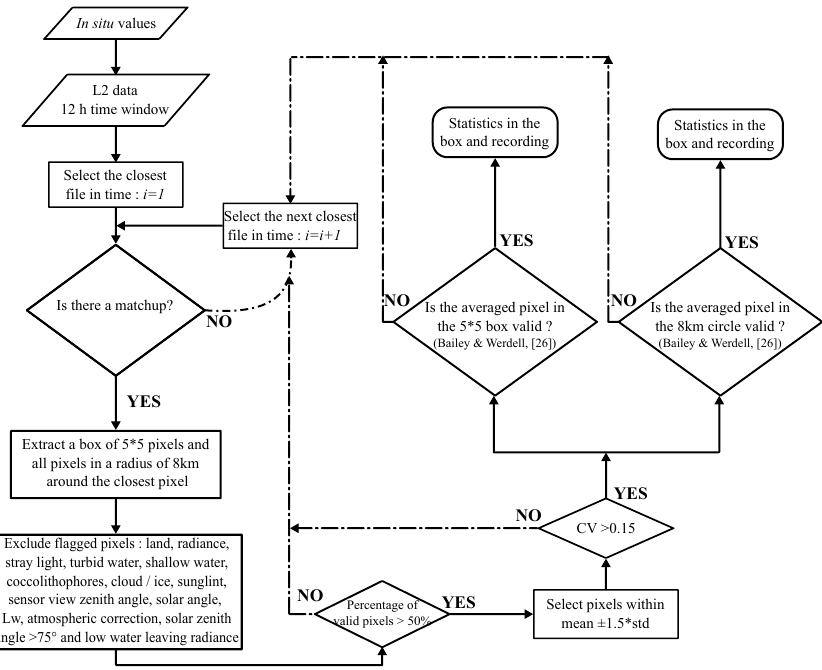
Figure 1. Flowchart of the procedures applied to extract the satellite values.